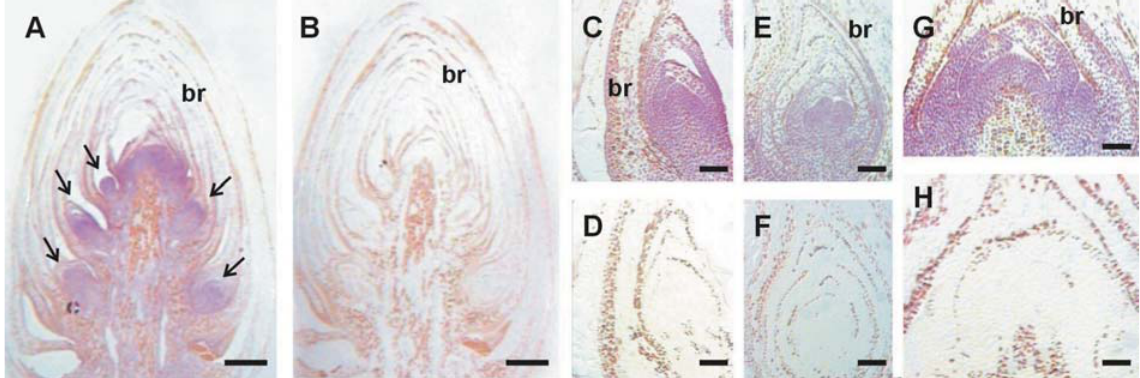
Figure 5 - In situ localization of PcFY transcripts. All sections are longitudinal. The pink-purple color indicates the hybridization signal. Hybridizations were performed with an antisense probe in A, C, E and G. In B, D, F and H a sense probe was used. In this case, no hybridization signal was observed abovebackgroundlevel.AandB:Long-branchapexduringtheinitiationofaxillarymeristems(arrows)onthesideofapicalmeristem;CandD:develop- ing short-branch female cone with initiating bract primordia (br). E and F: developing short-branch male cone with initiating bract primordia (br). G and H: Detail of an apical meristem of an adult (15 years-old) plant. Bars: A and B: 600 µ m; C-F: 250 µ m; G and H: 100 µ